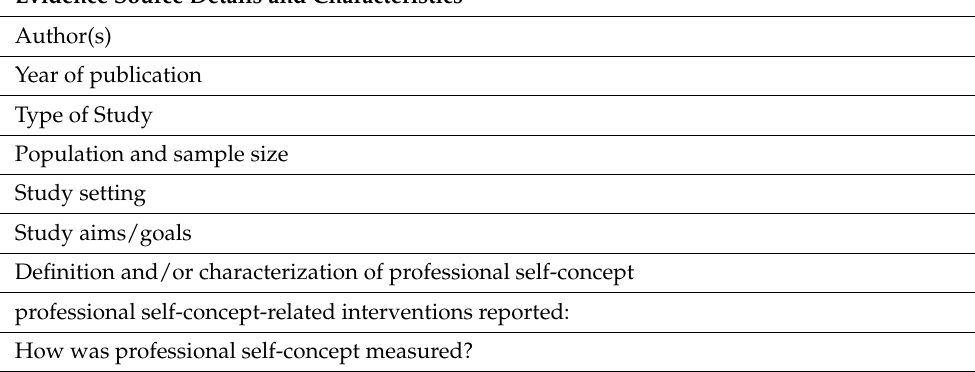
Table 2. Data extraction